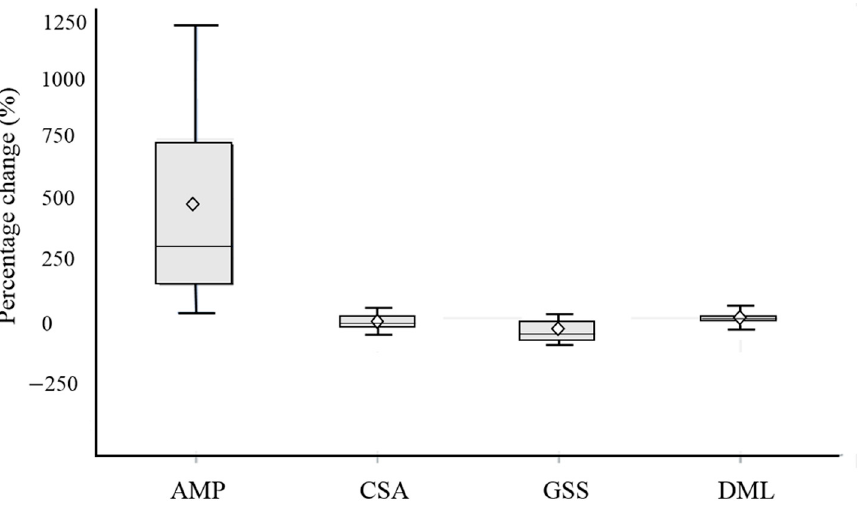
Figure 4. Boxplot of the percentage change in AMP, CSA, GSS, and DML values at the fourth week in the steroid group from baseline.